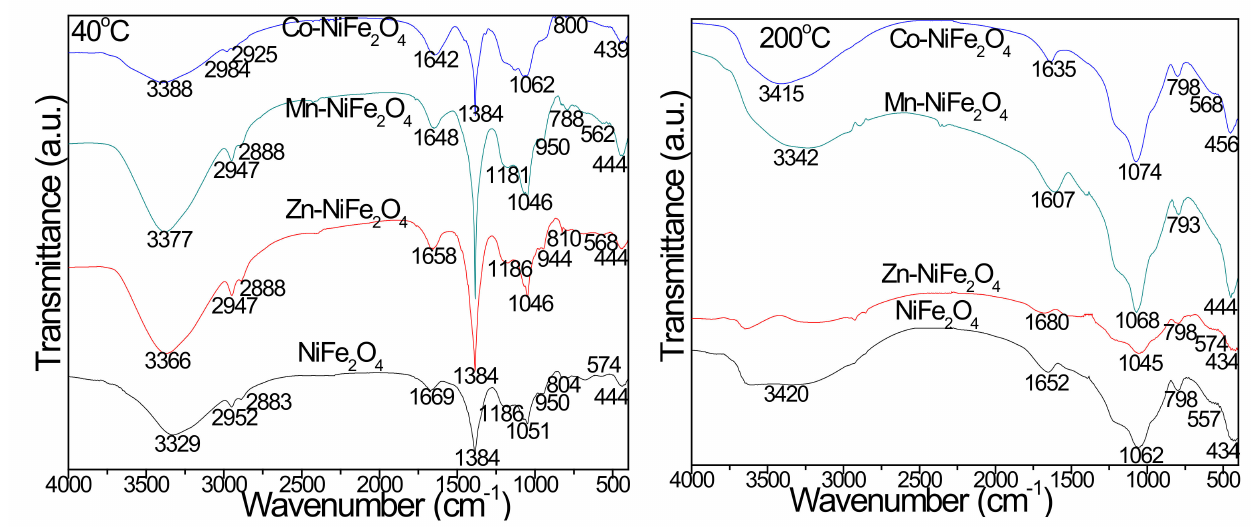
Figure 3. FT-IR spectra of virgin and doped NiFe 2 O 4 (Zn-NiFe 2 O 4 , Mn-NiFe 2 O 4 , Co-NiFe 2 O 4 ) heated at 40 and 200 ◦